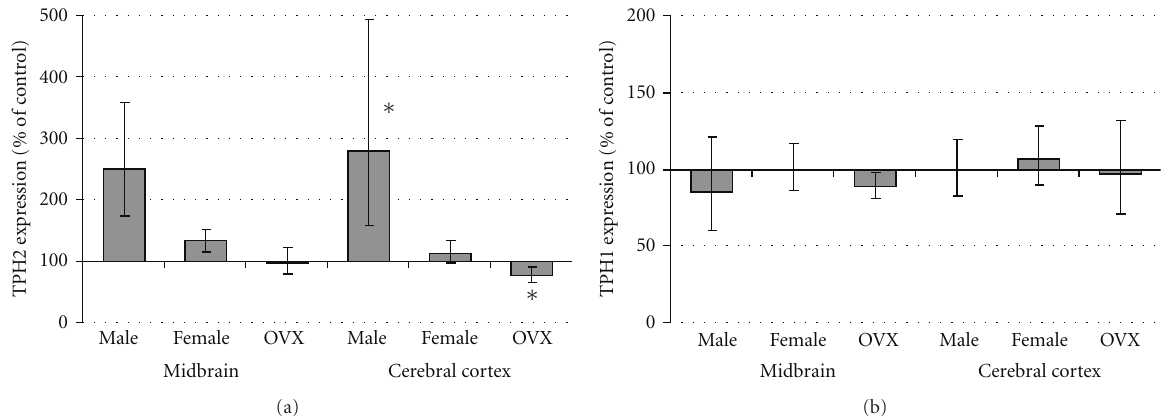
Figure 4: Cerebral cortex expression of TPH2 mRNA is increased in SSRI-exposed male mice. PCR was performed on midbrain and cerebral cortex homogenates obtained from control and SSRI-exposed mice (gray bars). Expression of the two tryptophan hydroxylase isoforms (TPH2 and TPH1) was normalized by GAPDH and ΔΔ CT values were calculated to determine relative mRNA abundance. N = 5–10 mice from 5–8 litters per group; ∗ P < 0 . 05 versus control by ANOVA with the Holm-Sidak method for multiple comparisons.